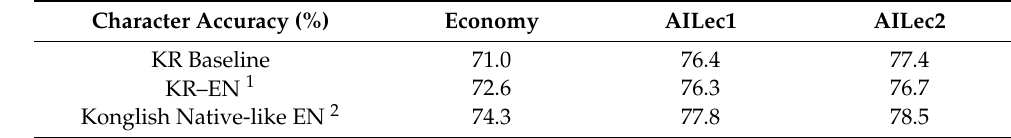
Table 3. Character accuracy of KR baseline, KR–EN, and Konglish native-like